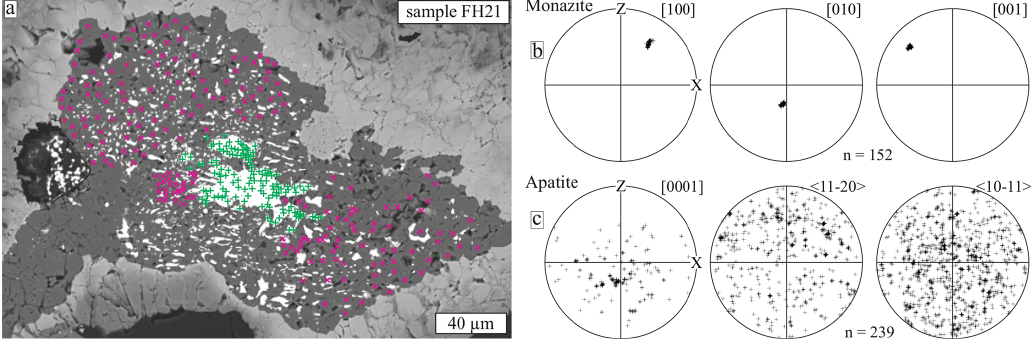
Figure 12. EBSD point measurements on fluorapatite and monazite. (a) BSE image showing the measurement locations: pink for fluorapatite and green for monazite. (b, c) Pole figures (equal angle projection of the lower hemisphere) for monazite (b) and fluorapatite (c)